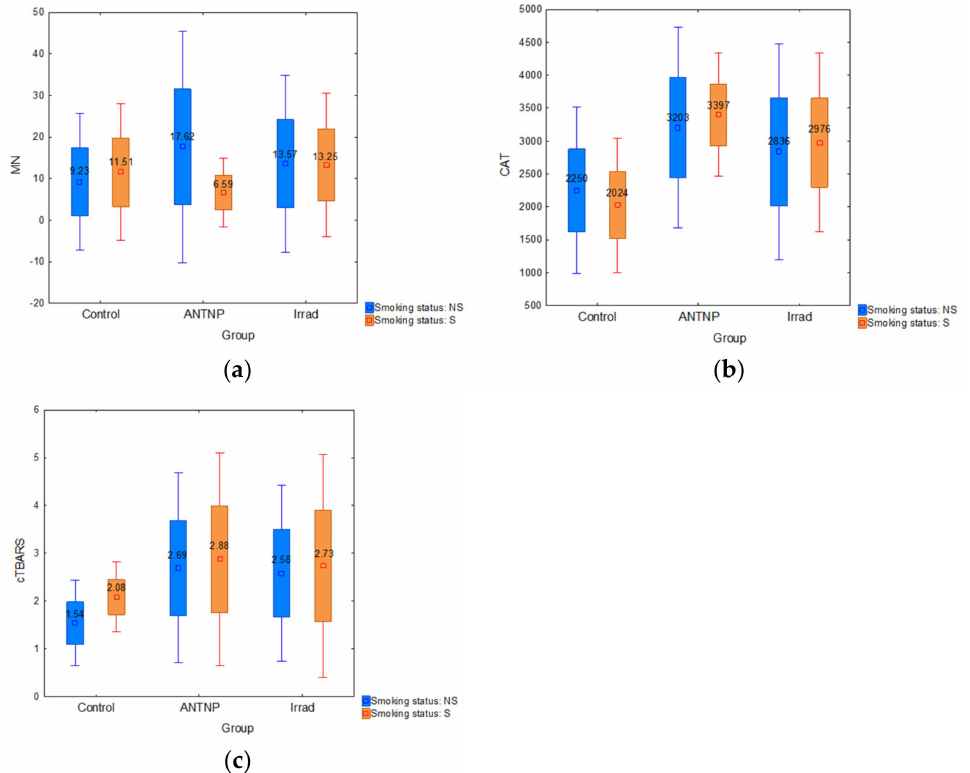
Figure 4. The impact of smoking: ( a ) micronucleus frequency (number of micronuclei per 1000 examined binuclear cells); ( b ) catalase activity (U/g Hgb); ( c ) cTBARS (nmol of